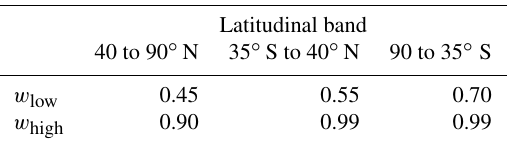
Table A1. The upper and lower soil wetness thresholds for three latitudinal bands used in Eq. (1) to determine fractional wetland coverage in a given grid cell.